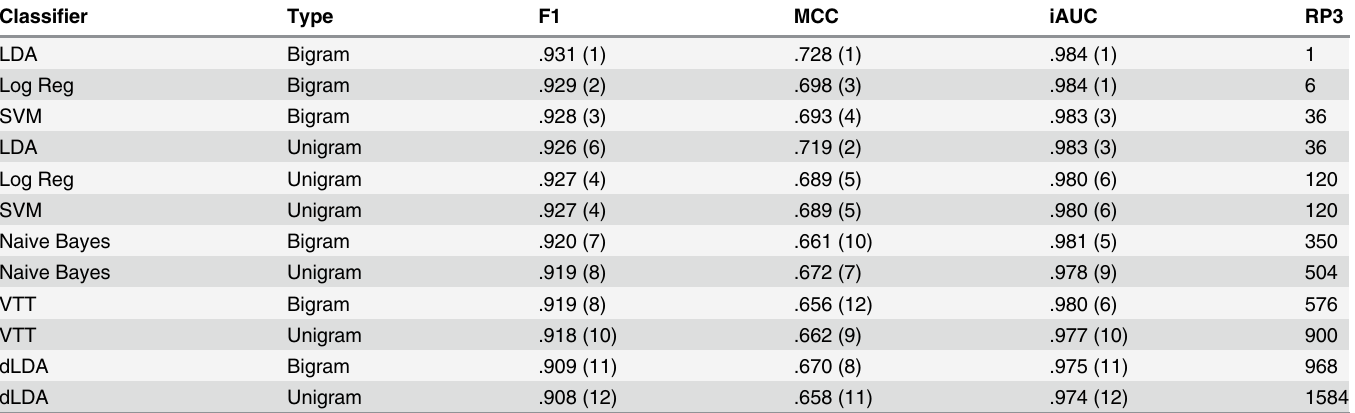
Table 1. Classification performance on abstracts. Performance for both unigram and bigram runs on non-transformed features according to F1, MCC, and iAUC performance measures. The rank of the classifiers according to each measure is reported in parenthesis in the respective column. Classifiers are or- dered according to the rank product (RP3) of the three measures (last